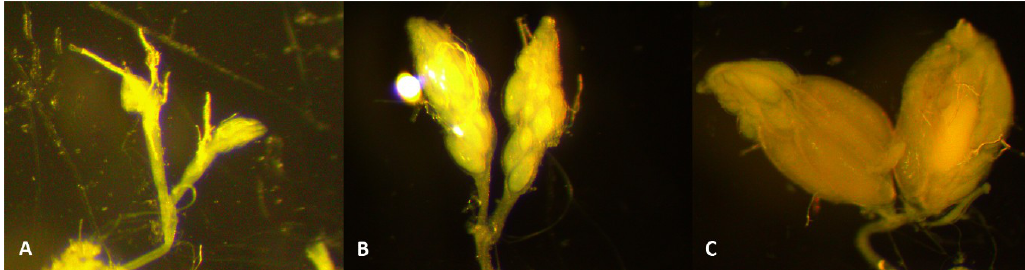
Figure 2. Ovarian development of D. suzukii female: ( A ) unripe ovarioles, ( B ) maturing eggs, ( C ) mature eggs (magnification: 40×). Photographs: A.D.C.P.